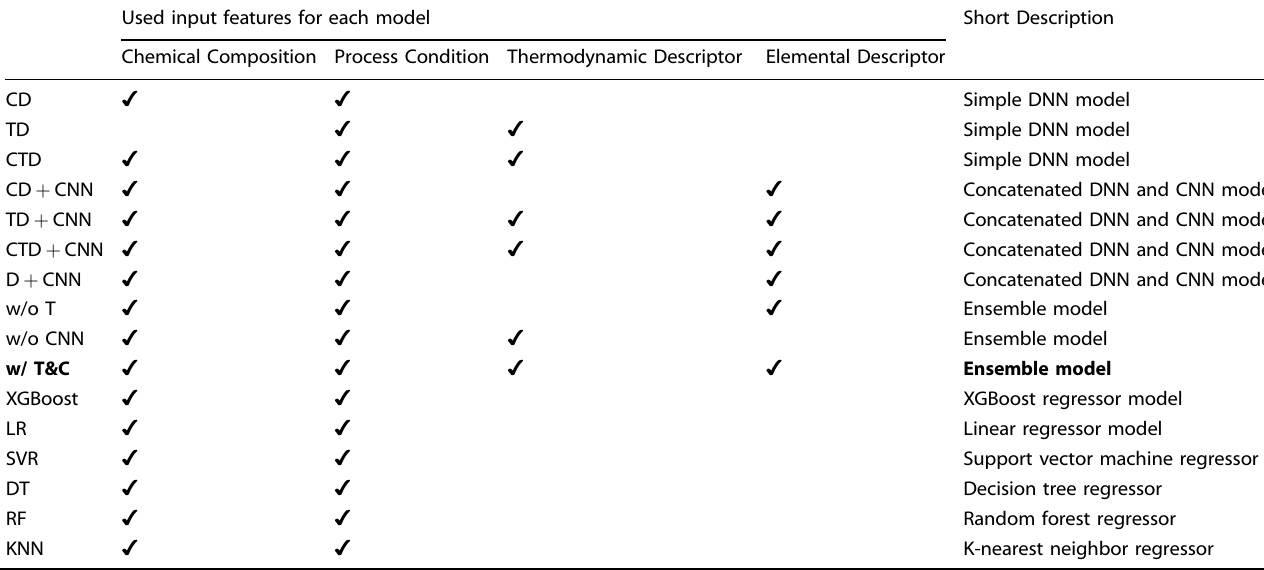
Table 1. Used input features and short description for the machine learning